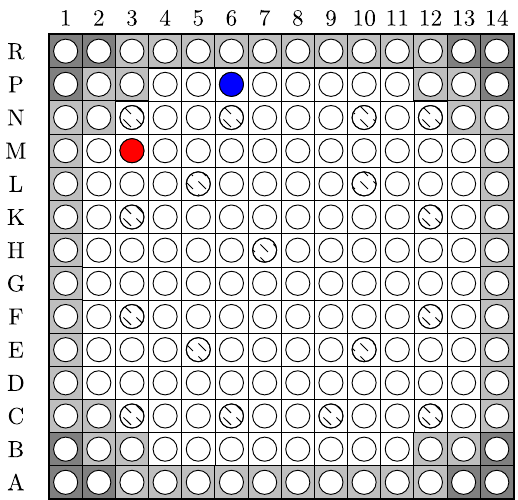
Fig. 1. Radial locations of the rods containing the BM1 (red) and BM3 (blue) samples in the assembly M109. The variations of gray represent different Pu enrichments. Water channels are indicated by dashes